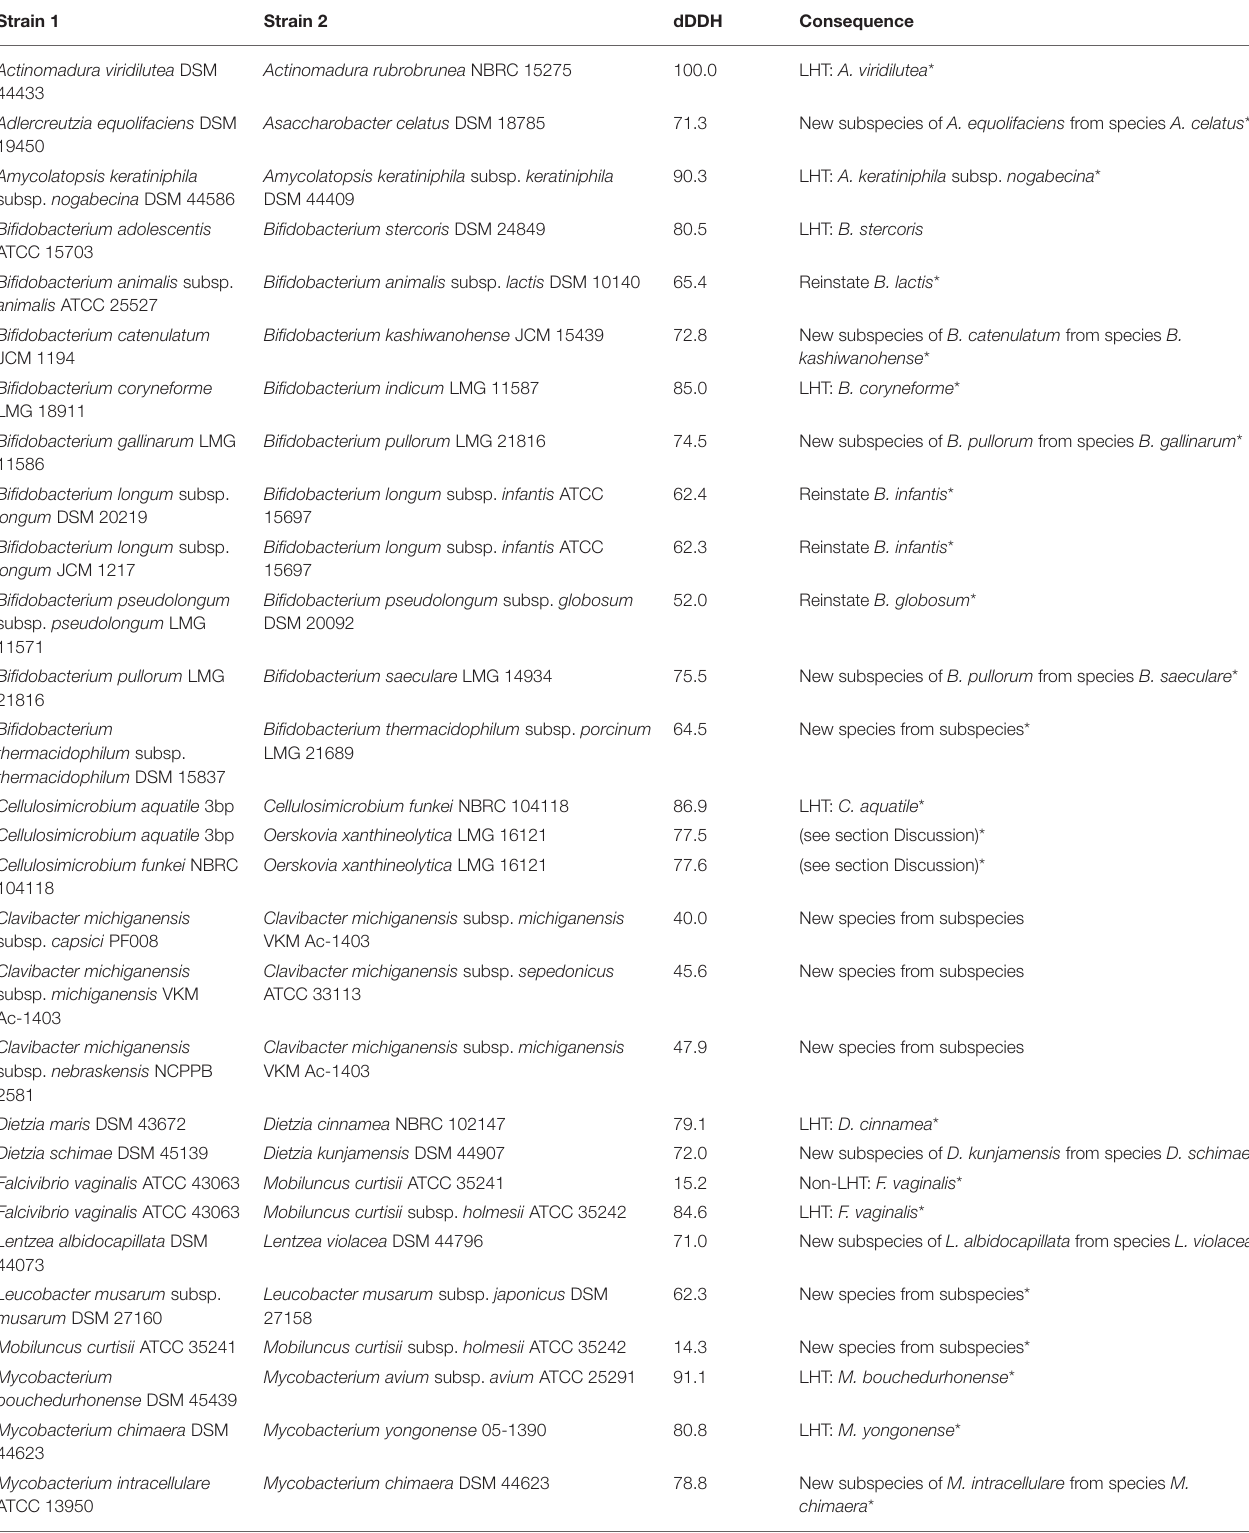
TABLE 1 | Outcome of applying GGDC to calculate intergenomic dDDH values. Strain